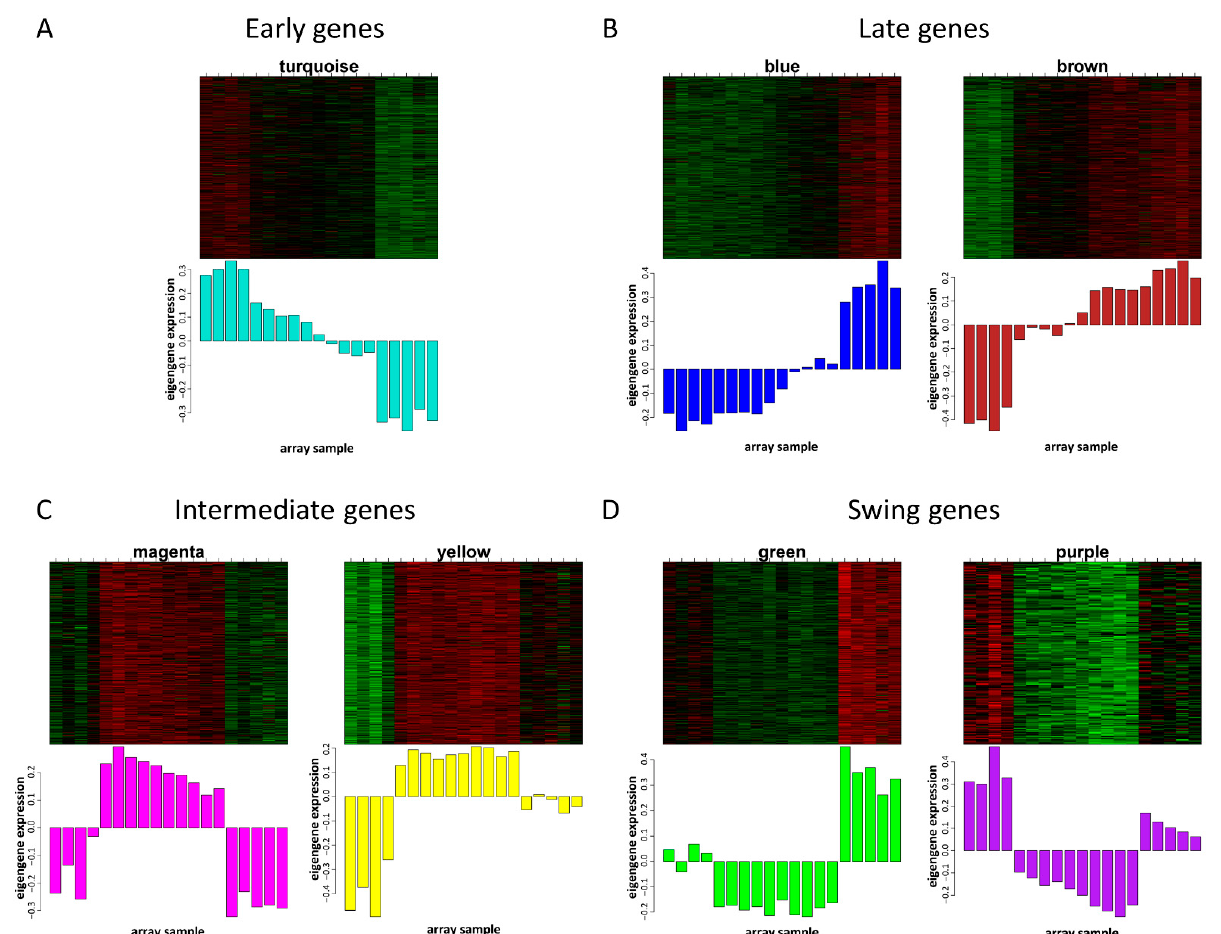
Figure 3. Gene expression patterns of different modules during mouse hindlimb development. Gene expression pattern of ( A ) early genes in module turquoise, ( B ) late genes in modules blue and brown, ( C ) intermediate genes in modules magenta and yellow, ( D ) swing genes in modules green and purple. Each figure above represents a heatmap of gene expression, and each figure below represents a histogram of gene expression across different